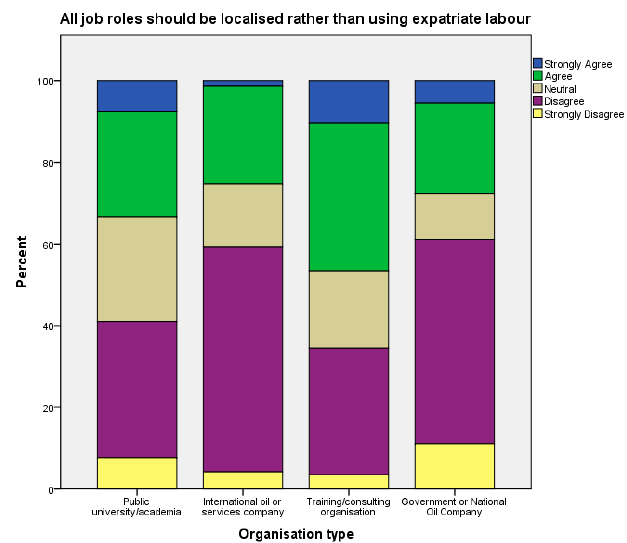
Figure 1. Responses by organization type to “all job roles should be localized rather than using expatriate labour”.